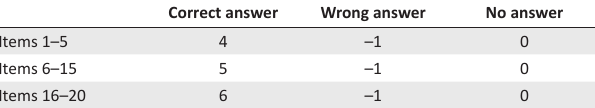
TABLE 1: Weighting and penalty procedure and random guess score. Correct